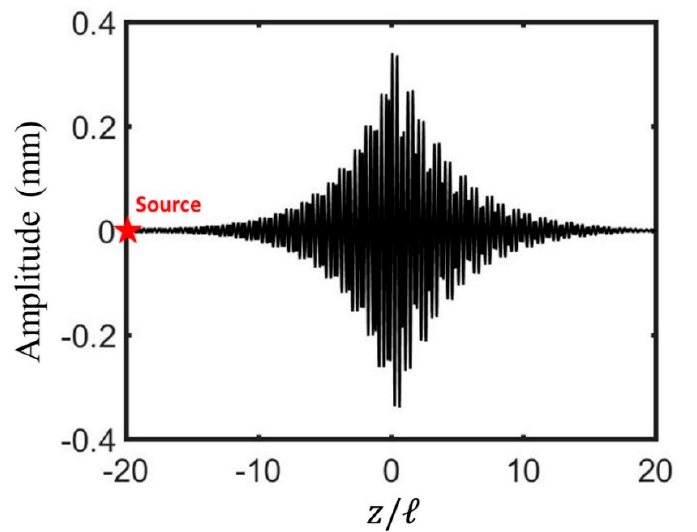
Figure 7. The interface mode of the ES-I / ES-II composite system can be excited by dimensionless frequency 2.82.